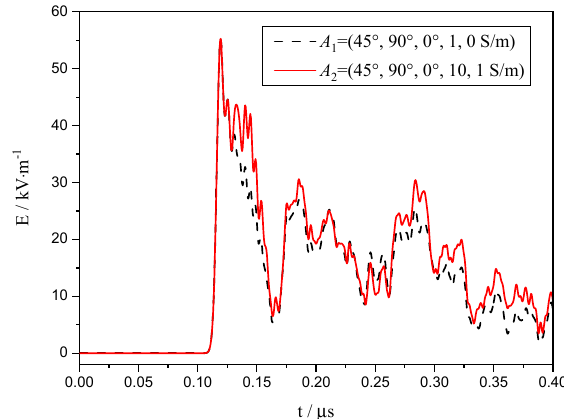
Figure 8. Comparison of coupling electric field in free space and half-space cases.